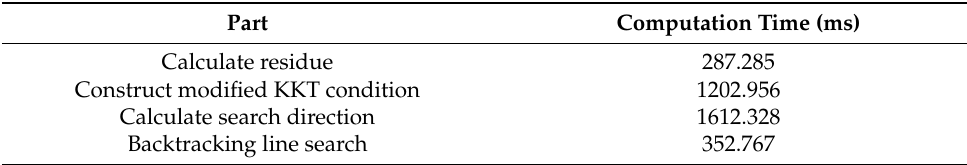
Table 2. The computation time for each part of PD-IPM.